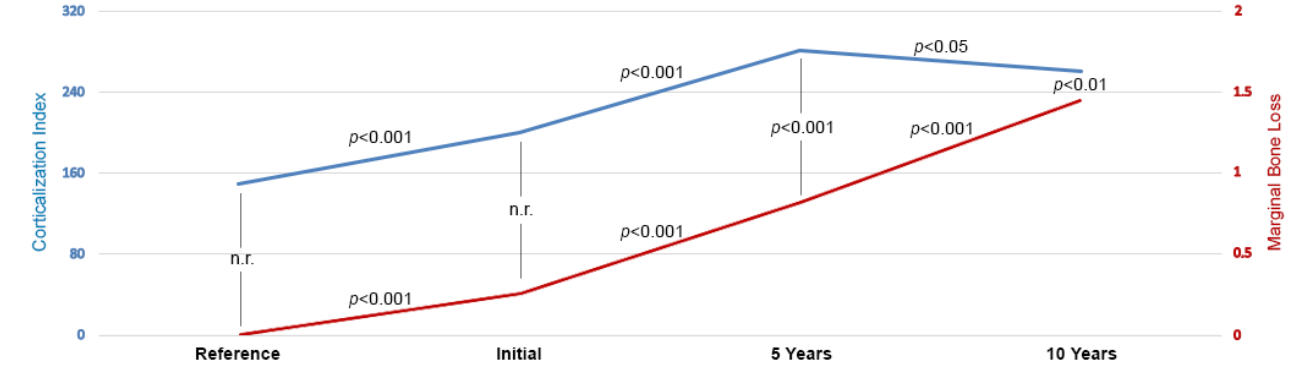
Figure 3. The results of peri-implant bone corticalization assessment (corticalization index, blue line, data without a unit) and marginal bone loss (red line, data in millimeters). There was a statistically significant increase in the values of both variables at each stage of the study. Moreover, it was noted that there was a directly proportional relationship of marginal bone loss with the progression of corticalization at 5 years and 10 years of functional loading of the implants. Abbreviations: n.r.—no